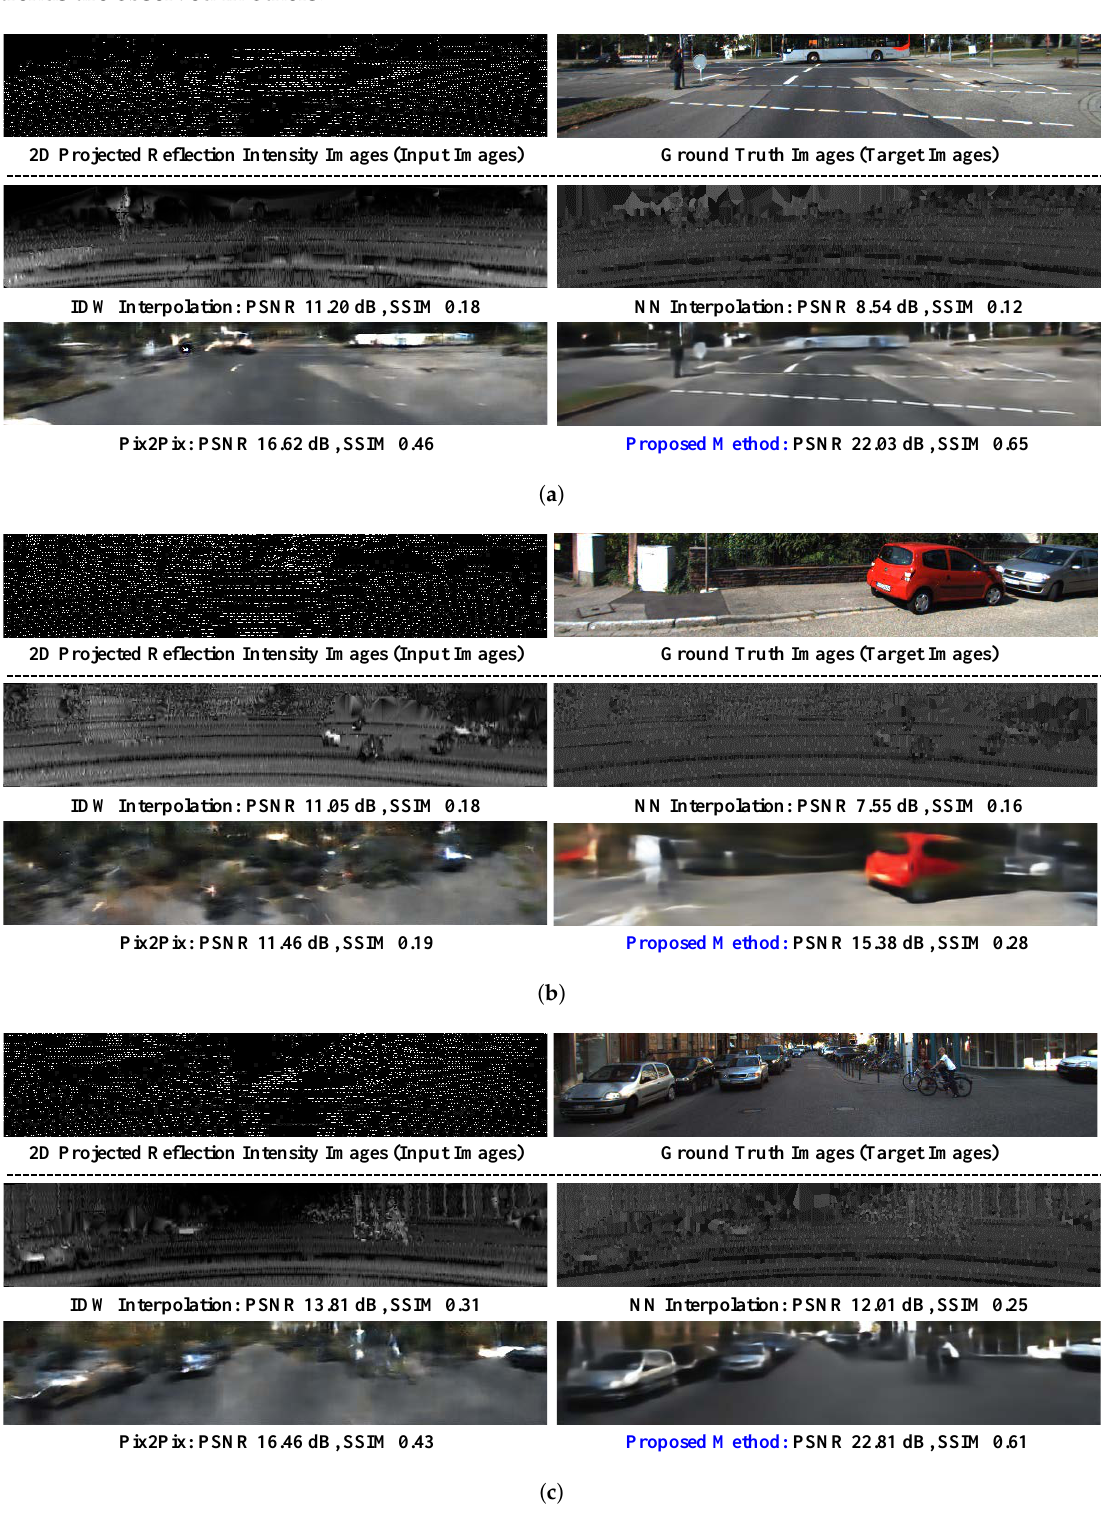
Figure 8. Inference examples in the validation and test dataset. (a) Case images with bus and road lanes; (b) Case images captured at short distance; and (c) Case images with vehicles at various distances are